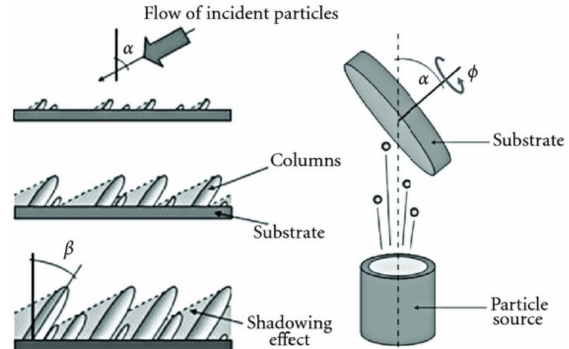
Figure 1. Schematic description of the ballistic shadowing e ff ect during thin-film growth in glancing angle geometry (reproduced from [25], Hindawi,